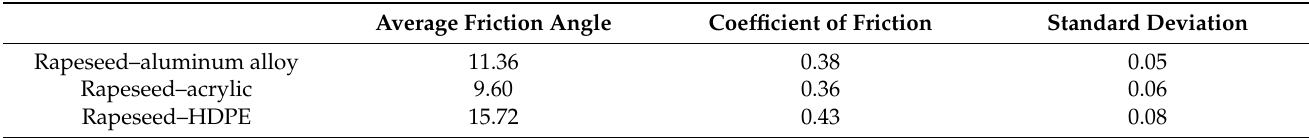
Figure 1. The metering device for measuring the sliding friction angle between rapeseed and the contact materials. Table 2. Coefficient of static friction values between rapeseed and the contact materials.